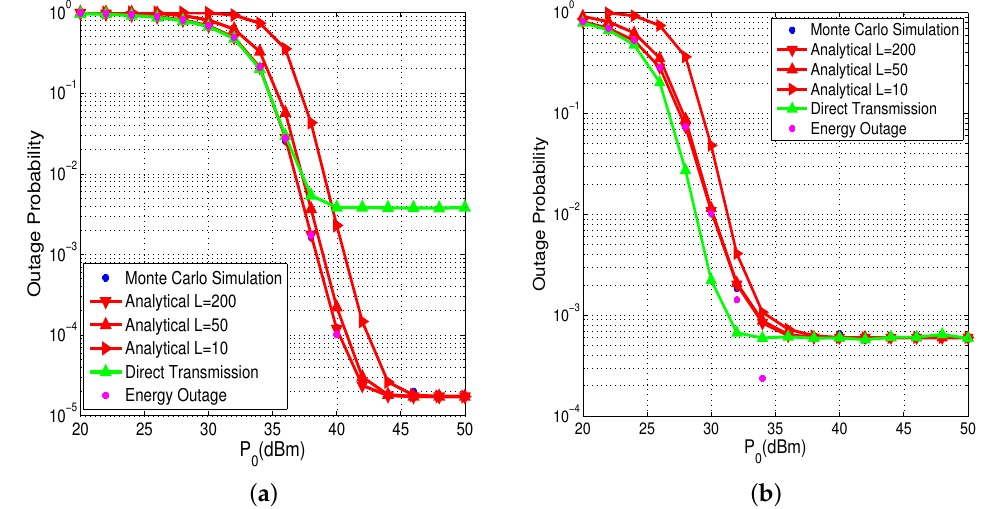
Figure 3. Outage probability of sensor in the far and near clusters versus the HAP transmit power P 0 . ( a ) far cluster; ( b ) near cluster.